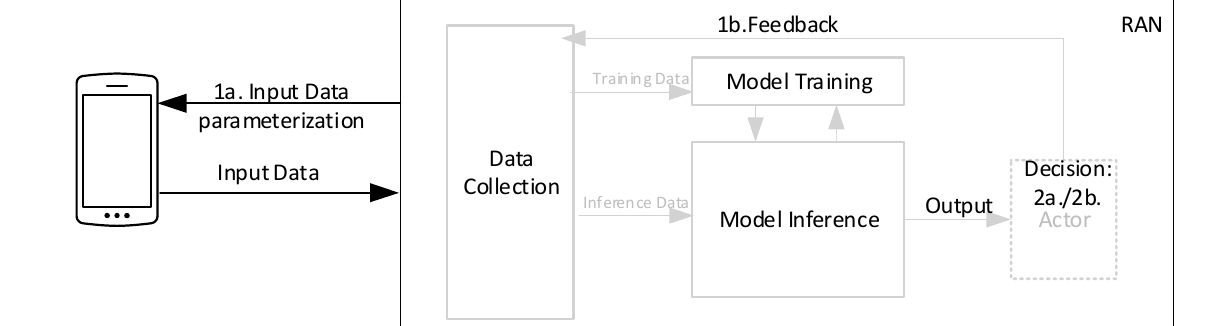
Figure 6. Applying AI/ML-based 5G RAN performance evaluation based on a 3GPP-assumed paradigm.